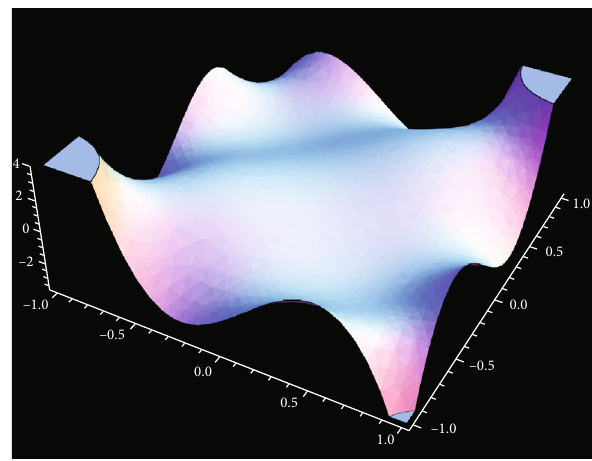
y Þ with n = 3, α = β = 0 : 5 x ð